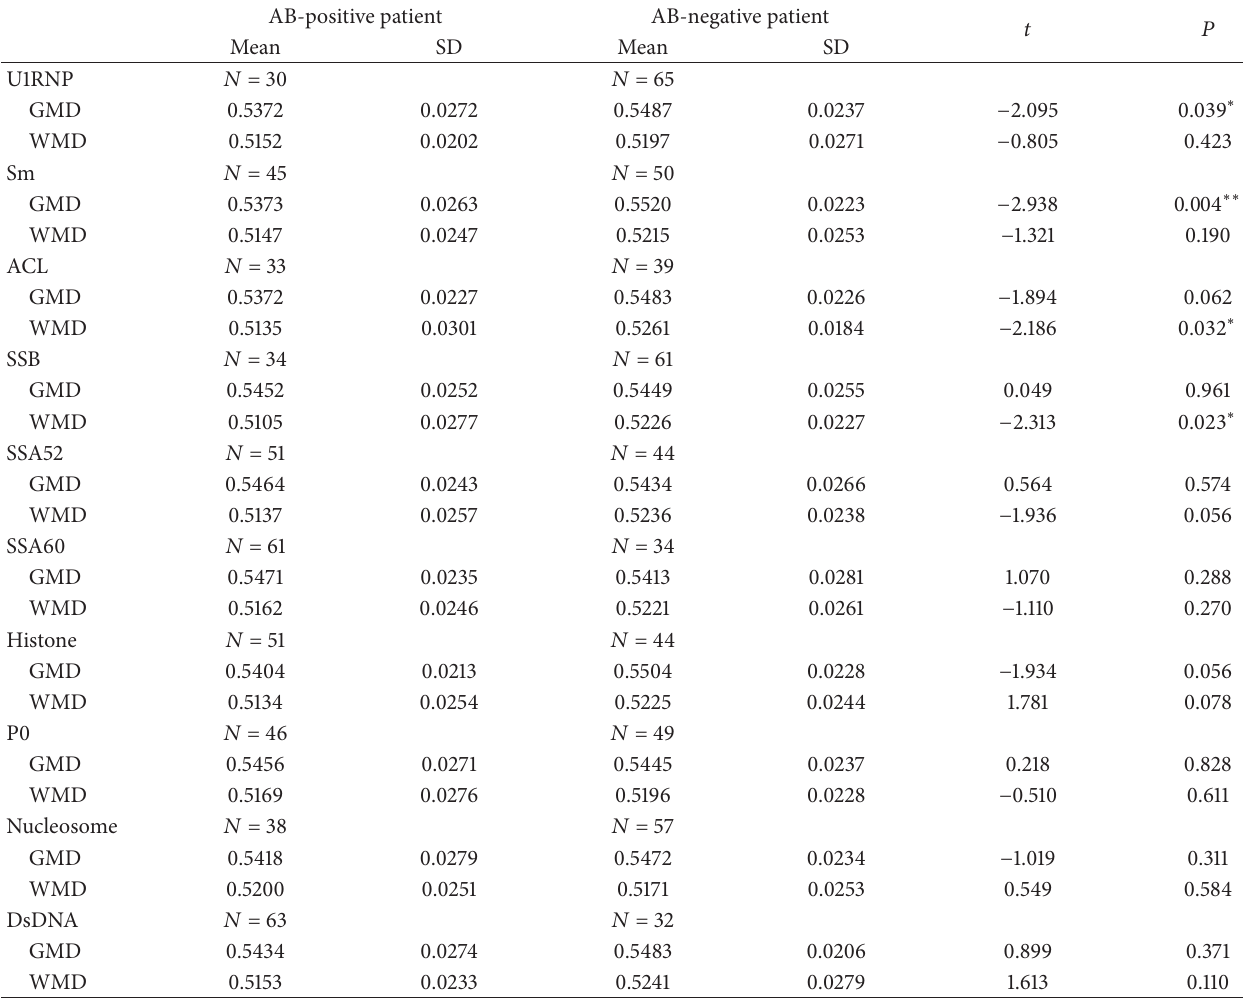
Table 3: GMD/WMD comparison between autoantibody-positive and -negative patients. AB-positive patient AB-negative